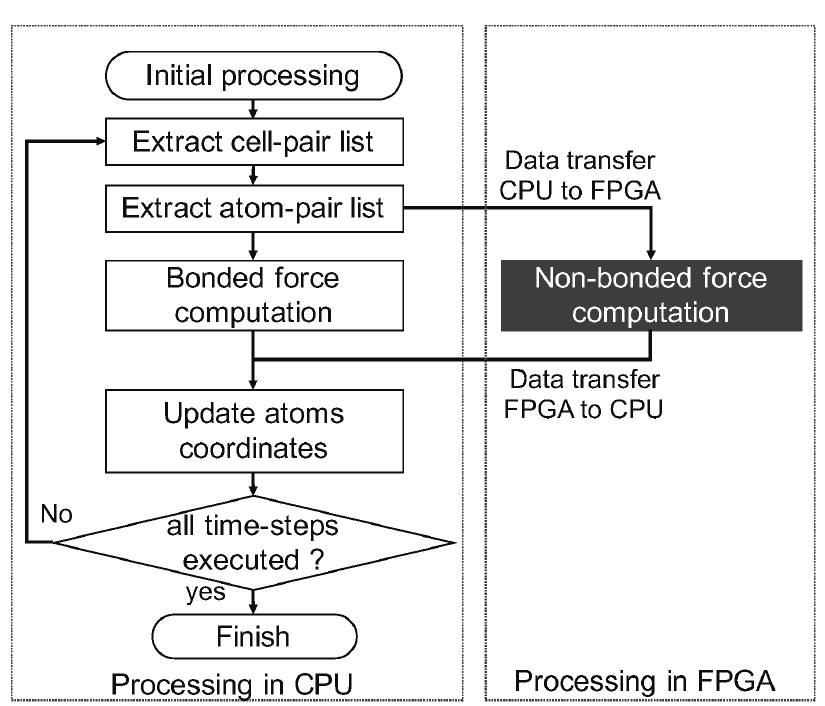
Fig. 6. Flow-chart of the CPU-FPGA heterogeneous pro-